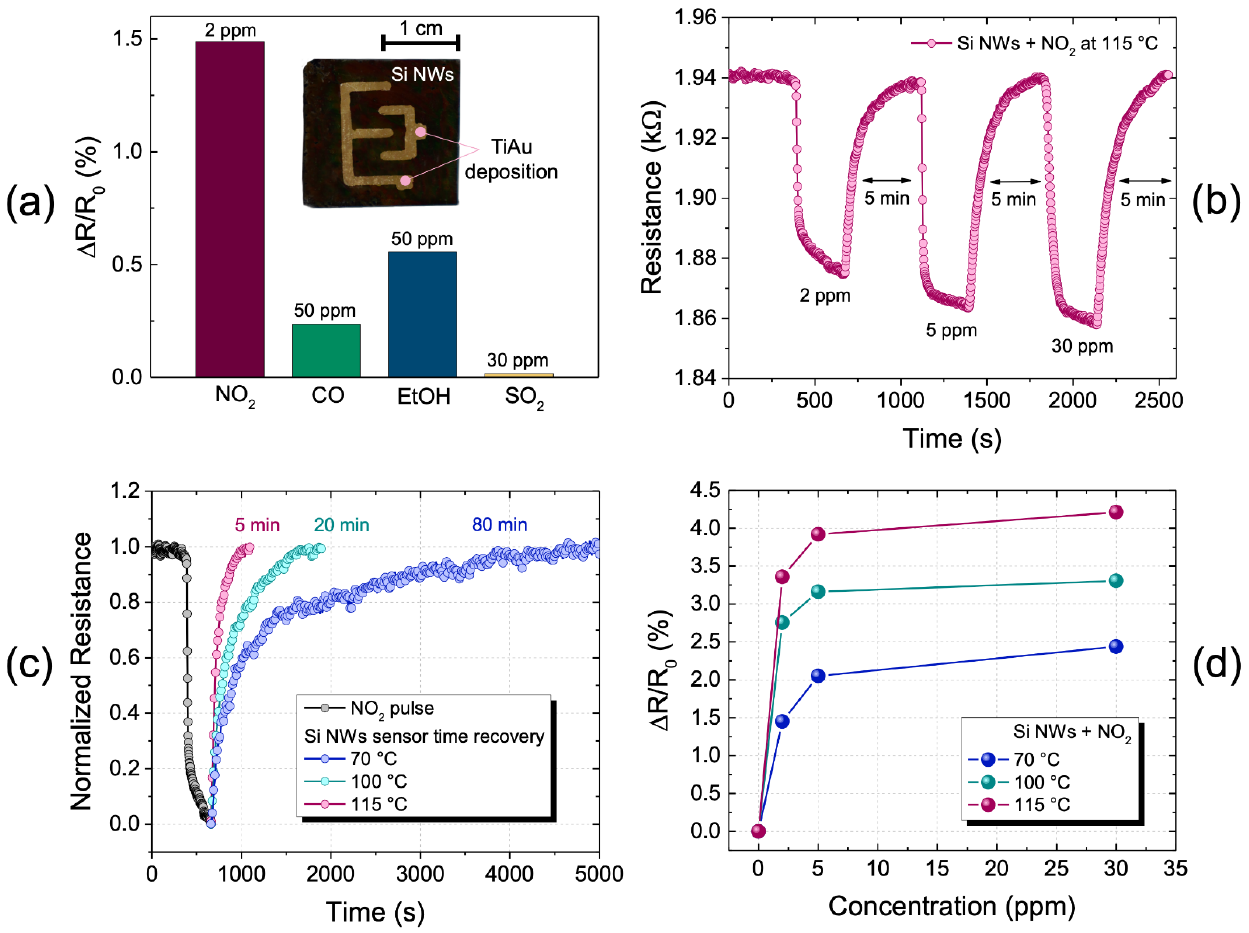
Figure 3. ( a ) photograph of the sensor (2 × 2.3 cm 2 ) made up of Si NWs (black color) covered by the interdigitated electrode of 100 nm Au above 5 nm of Ti. ( b ) Measurement of electrical resistance of the sensor exposed to 2, 5, and 30 ppm of NO 2 pulses at 115 °C. ( c ) Sensor recovery times after 5 min of NO 2 pulse at 2 ppm at 70, 100, and 115 °C. ( d ) Variation of the sensor resistance as a function of the NO 2 concentration at 70, 100, and 115 °C.